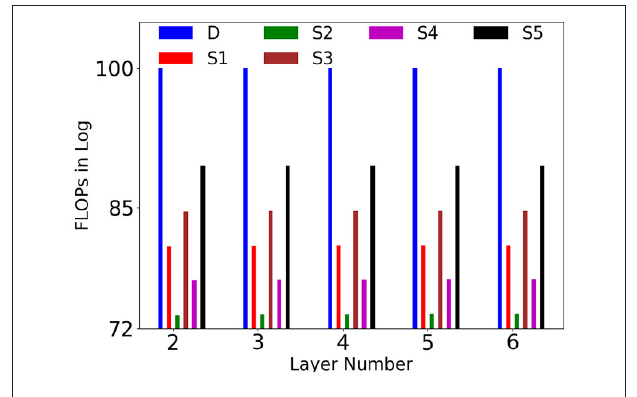
FIGURE 8 | Comparison of the computational complexity of dense (D) and SSC layers (y axis is in log scale), S1 (cid:16) N a N a = 0.0625, N 2 k = 1 (cid:17) , S3 (cid:16) N a (cid:16) mn N a = 0.0625, N 2 k = 2 (cid:17) , S5 (cid:16) N a (cid:16) mn of FLOPs. For better visualization, FLOPs are converted into log and estimated as percentage of dense layer FLOP (cid:16) log S i